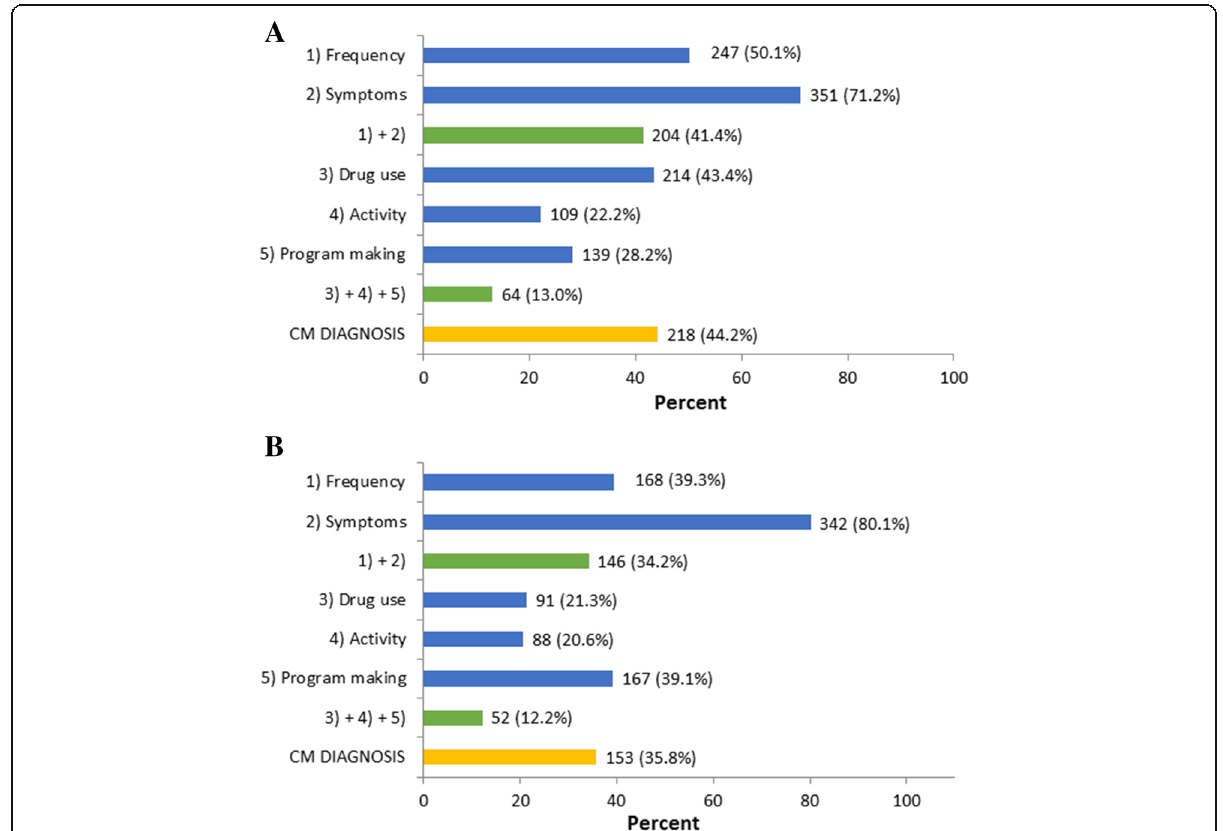
Fig. 3 Proportions of boxes checked in the ID-EC paper ( a ) and smart app ( b ) questionnaires